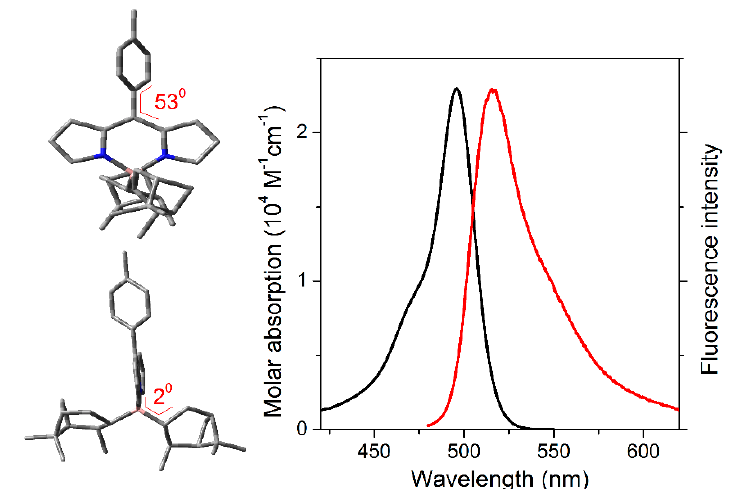
Figure 3. Absorption ( black ) and normalized fluorescence ( red ) spectra of 5 in diluted solution (2 mM) of methanol. The corresponding optimized ground state geometry (PCM-B3PYP/6-31g* in methanol) is also added ( top in a front view and bottom in a side view), together with key dihedral angles to highlight the orientation of the rings appended at 8-position and at the boron